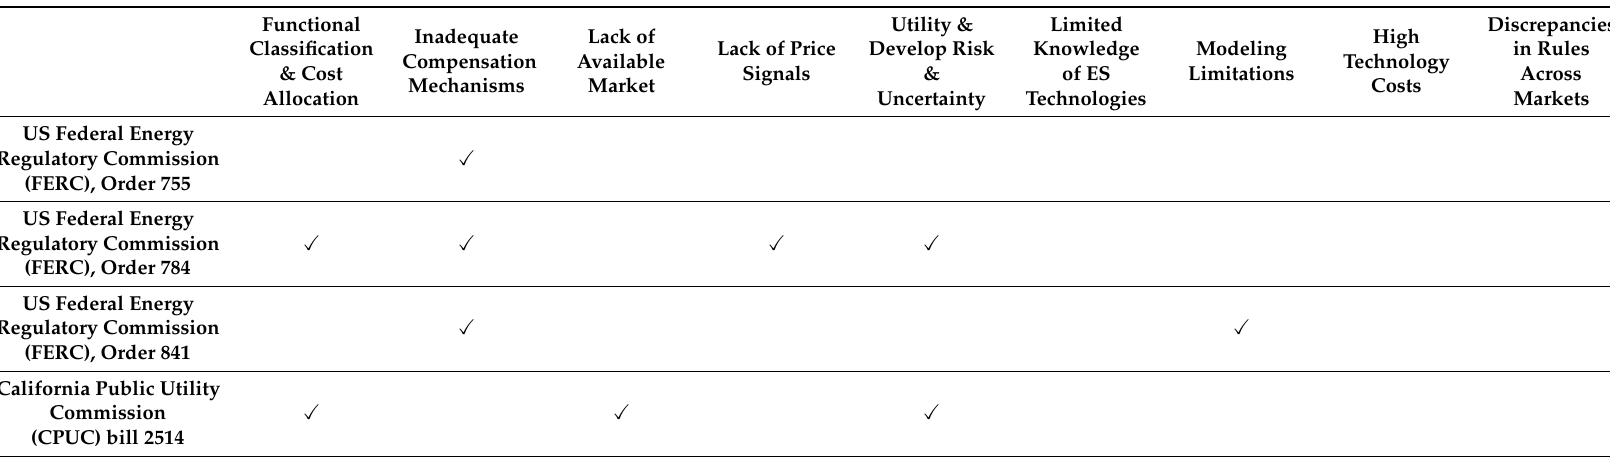
Table 24. Mapping of di ff erent types of policies taken by the regulatory organizations and what specific barriers they are